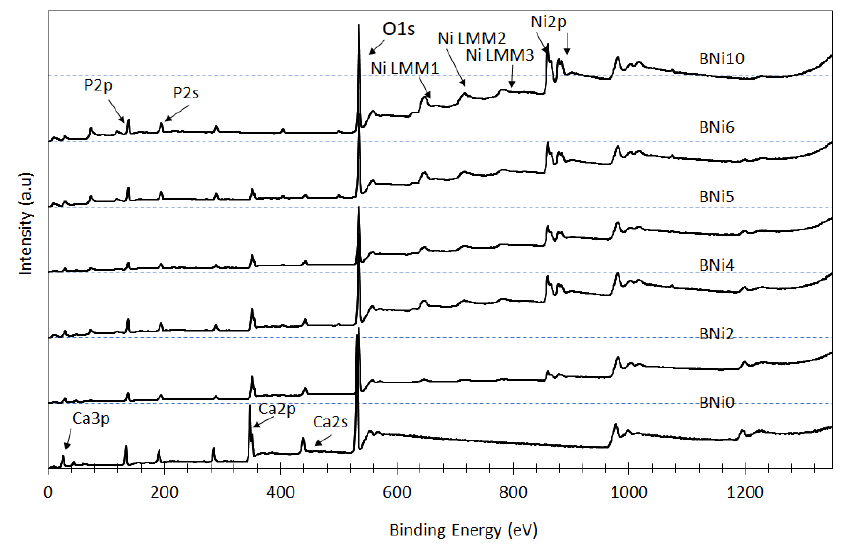
· nH 1 − x HPO 4 2 O